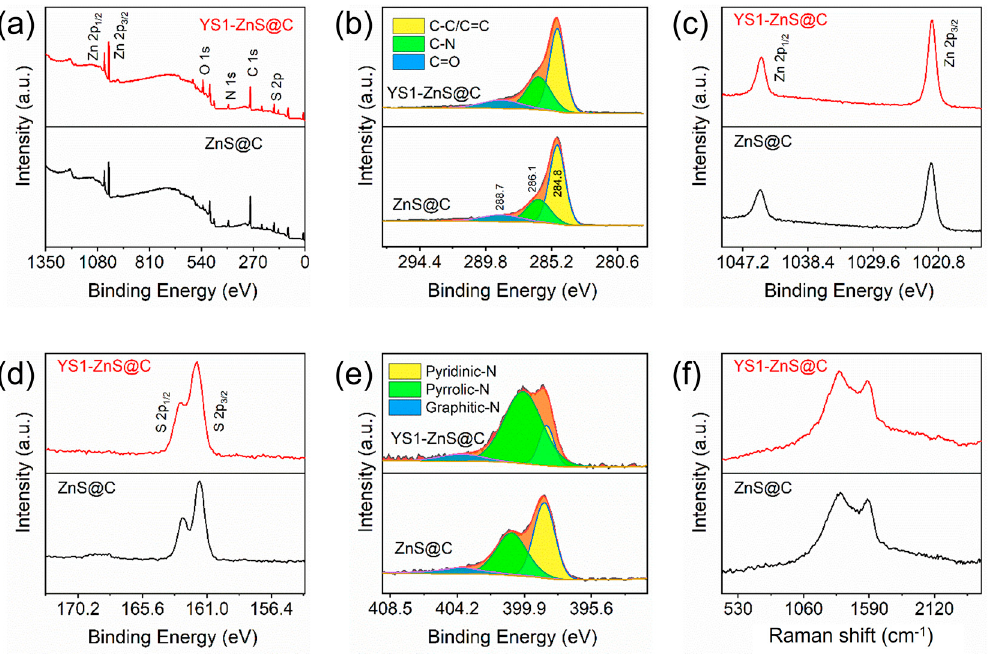
Figure 5. XPS spectra of ( a ) survey, ( b ) C 1s, ( c ) Zn 2p, ( d ) S 2p, and ( e ) N 1s. ( f ) Raman spectra for